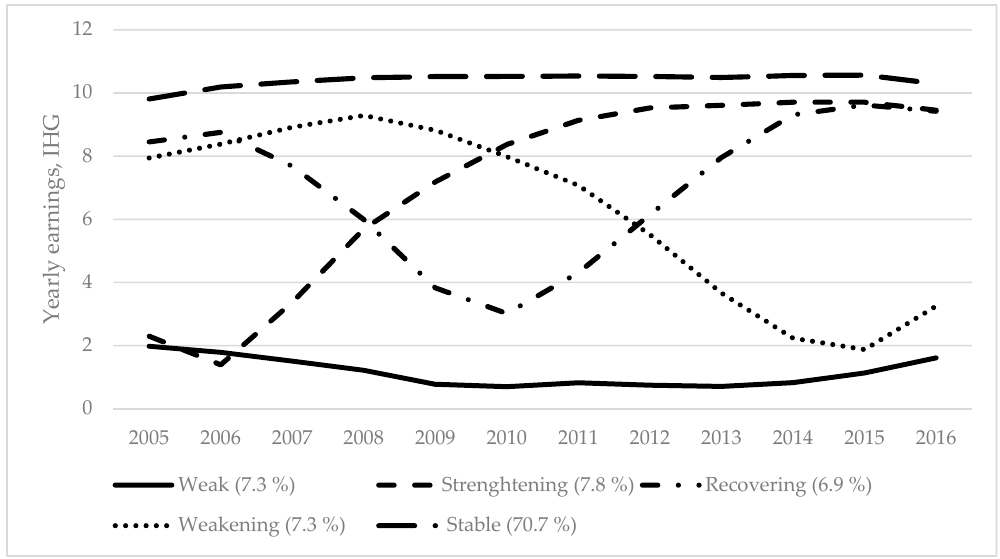
Figure 1. Women’s labour market attachment trajectories.